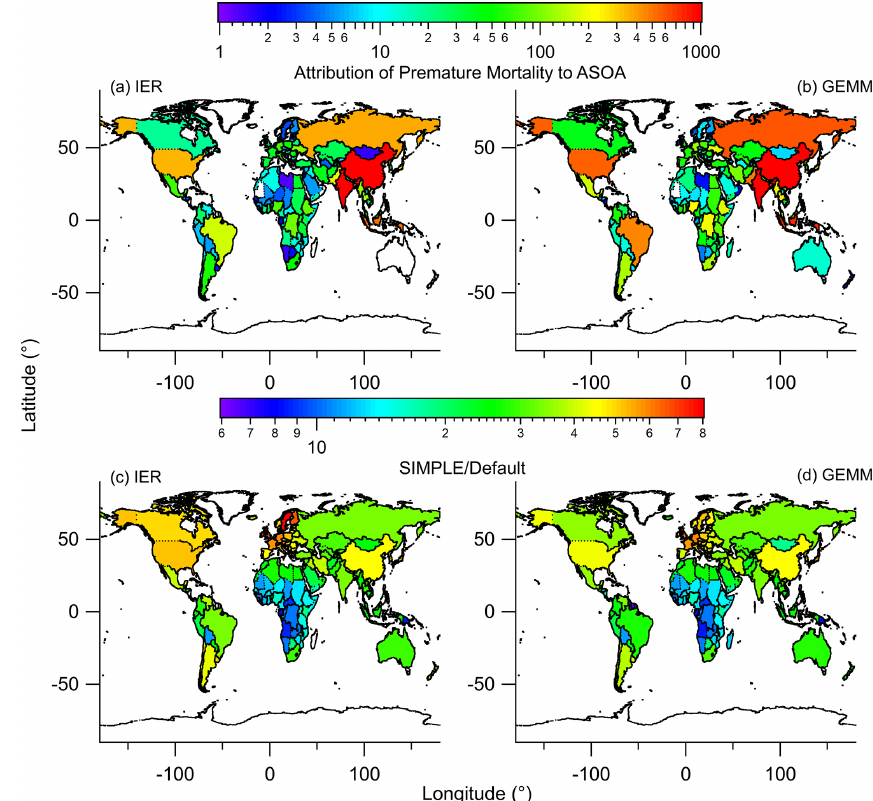
Figure 9. Attribution of premature mortality to ASOA with (a) IER or (b) GEMM, using the non-volatile primary OA and traditional SOA precursors method from prior studies (e.g., Ridley et al., 2018). The increase in the attribution of premature mortality to ASOA for the SIMPLE model (Fig. 8) versus the non-volatile primary OA and traditional SOA precursor method (default), for (c) IER and (d)